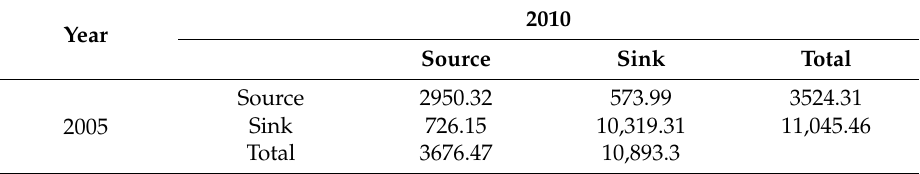
Table 27. The source-sink landscape transition matrix from 2005 to 2010 (km 2 ).